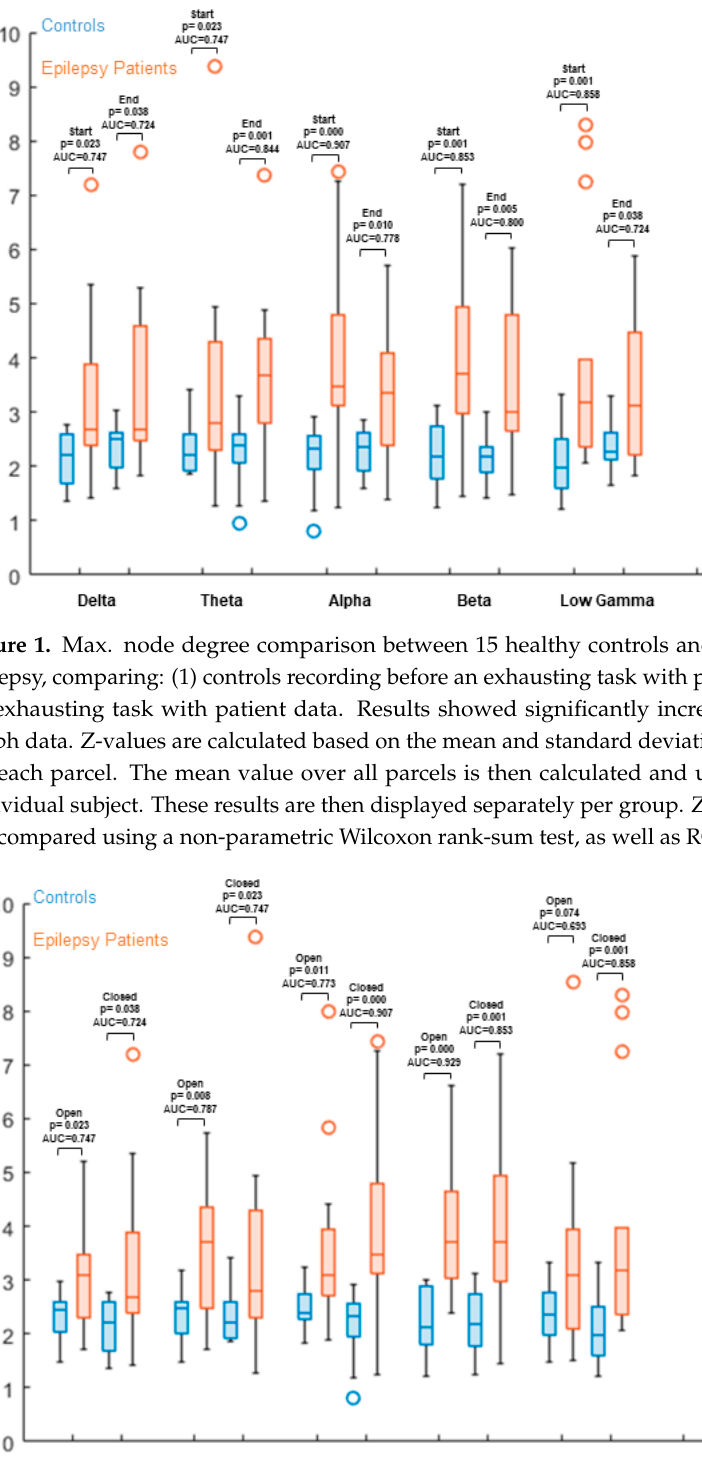
Figure 2. Max. node degree comparison between 15 healthy controls and 15 patients with focal epilepsy, comparing: (1) EO controls recording with EC patient data; and (2) EC control data with EC patient data. Results showed significantly increased values, as seen in the graph data. Z-values are calculated based on the mean and standard deviations of the control group, individually for each parcel. The mean value over all parcels is then calculated and used as the result for the individual subject. These results are then displayed separately per group. Z-values between groups are compared using a non-parametric Wilcoxon rank-sum test, as well as ROC AUC.